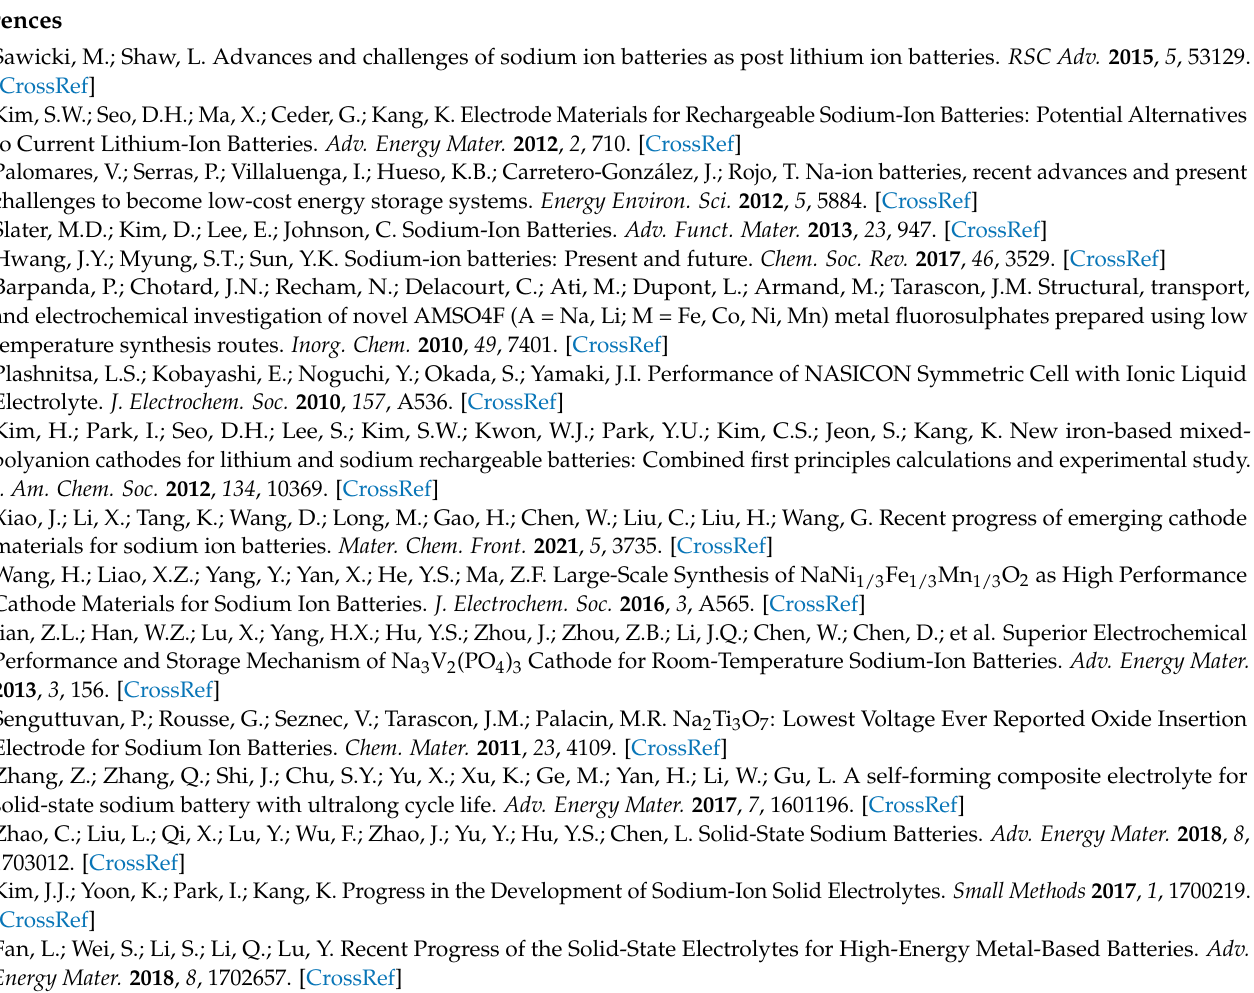
surfaces; Figure S2: (a) Ion-milled cross-sectional SEM image showing Na || NZSP symmetric cell deterioration through dendrite growth after cycling. The topmost and the bottom part represents the ion milling stub (b-g) Elemental mapping on the interface morphology of Na || NZSP (h) energy- dispersive X-ray spectroscopy (EDX) patterns of Na || Au-NZSP interface; Figure S3: (a) Cross- sectional SEM image of Na || Au-NZSP interface after cycling with no traces of dendritic growth, (b) Elemental mapping of the interface morphology of Na || Au-NZSP, (c) energy dispersive X-ray spectroscopy (EDX) patterns of Na || Au-NZSP